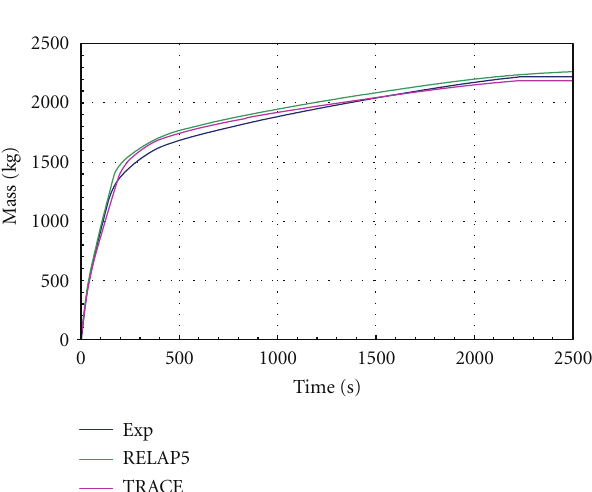
Figure 6: Mass flow rate at the break.